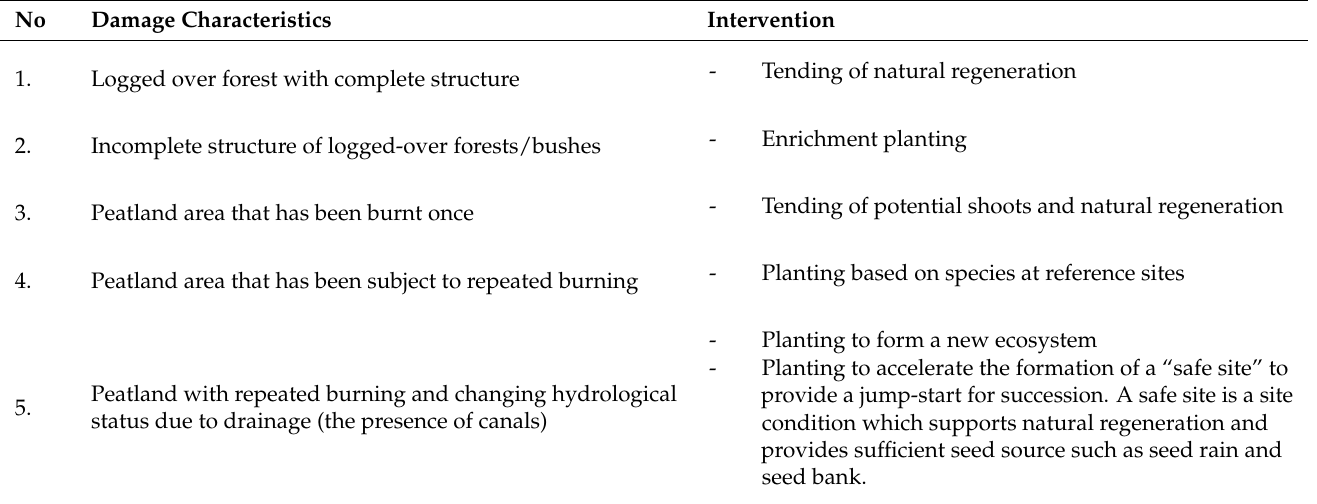
Table 2. Damage characteristics and choice of intervention for the success of degraded peatland